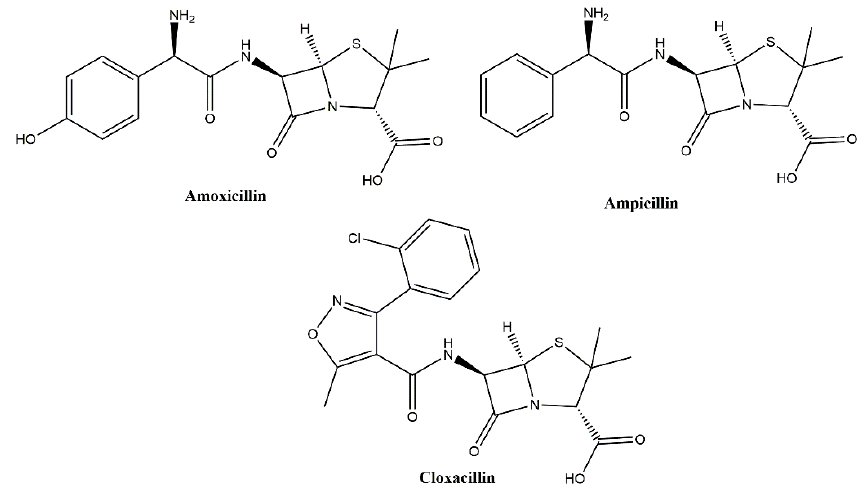
Figure 1. The chemical structures of amoxicillin, ampicillin, and cloxacillin.